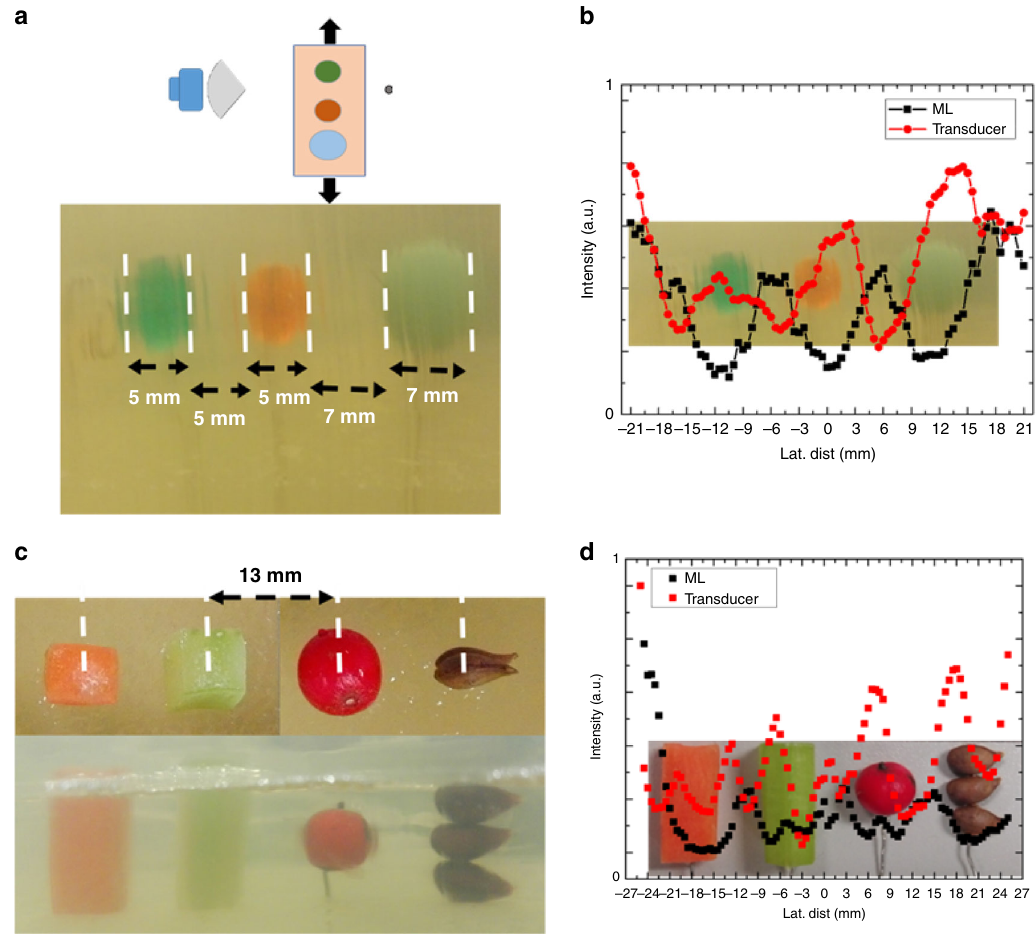
Fig. 4 Bistatic detection of objects in gelatin phantom using ML. a Spherical plastic beads of 5, 5, and 7 mm in a gelatin tissue phantom spaced 5, 5, and 7 mm apart at a depth of 30 mm. b Recorded scan of the beads with the transducer and lens in a bistatic arrangement overlayed with the known position of the beads in the tissue-approximating phantom. c Biomasses of celery, carrot, Yaupon berry, and apple seed to simulated masses in tissue. d Scan of biomasses overlayed with known position of masses at frequency of